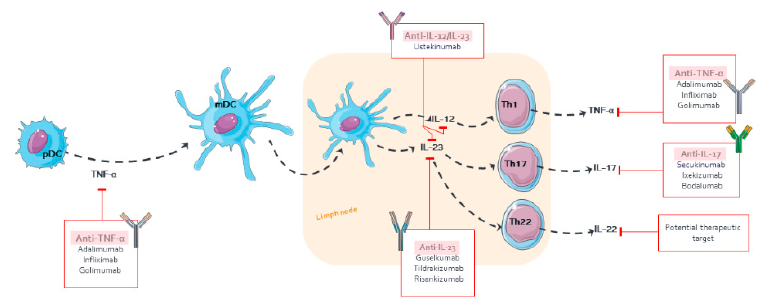
Figure 2. Pharmacological targets of monoclonal antibodies in psoriasis. Table 1. List of biologics approved for psoriasis.